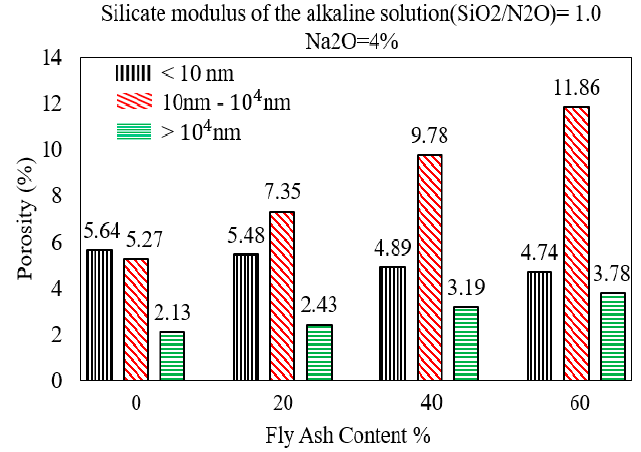
Figure 1. Effect of the fly ash content on the porosity of AASF mortars at the age of 28 days [38]. The compressive strength of mortar with an AASF binder is strongly correlated with the total porosity [38] and the volume of pores whose sizes range from 10 to 10 4 nm. Compressive strength decreases with an increase in overall porosity and an increase in the percentage of pores whose sizes fall in the range of 10 to 10 4 nm as shown in Figure 2 [38]. In addition, a trend exists where compressive strength increases with the percentage of air voids that are smaller than 10 nm and decreases with an increase in the percentage volume of larger air voids (>10 4 nm).